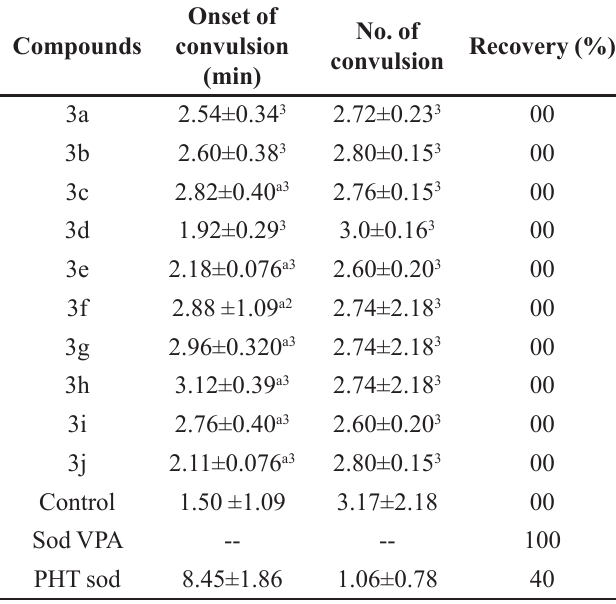
TABLE V - Anticonvulsant activities of 6-aryl-2-(imidazol-1-yl